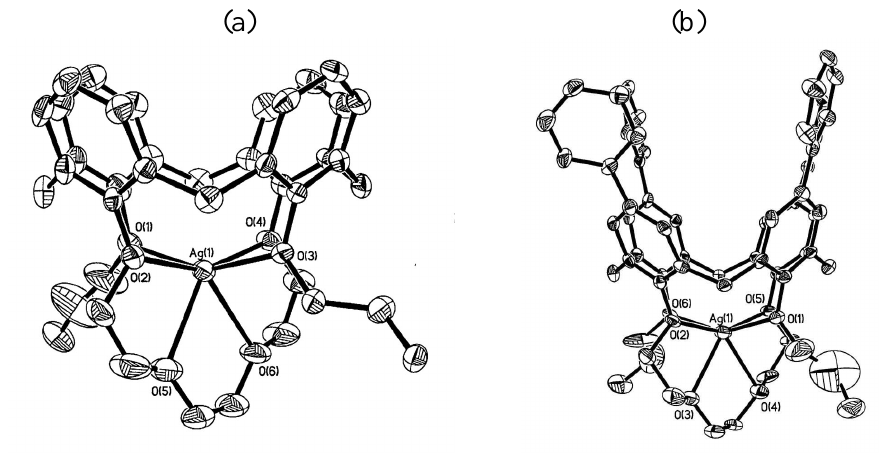
Figure 7. ORTEP drawings of (a) 3a·Ag + and (b) 3b·Ag + (25% probability). All hydrogen atoms are omitted for